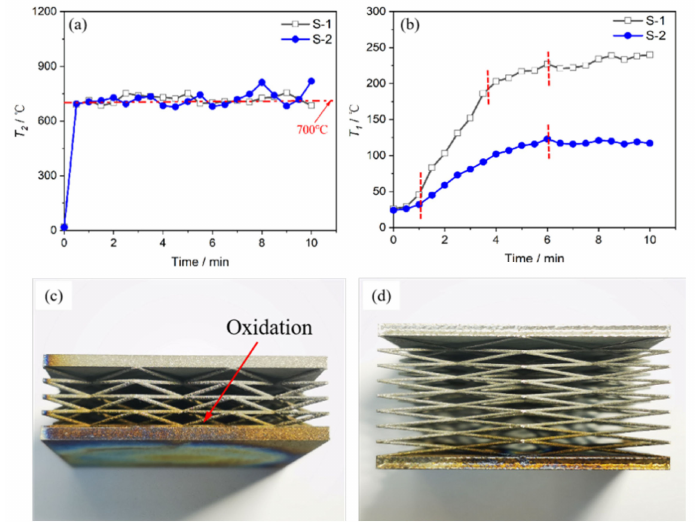
Figure 4. Thermal insulation performance of the BWR lattices: ( a ) Curve of T 2 with heating time; ( b ) Curve of T 1 with heating time;( c ) Image of S ‐ 1 after heating; ( d ) Image of S ‐ 2 after heating. The curve of insulated surface temperature ( T 1 /°C) with heating time was shown in